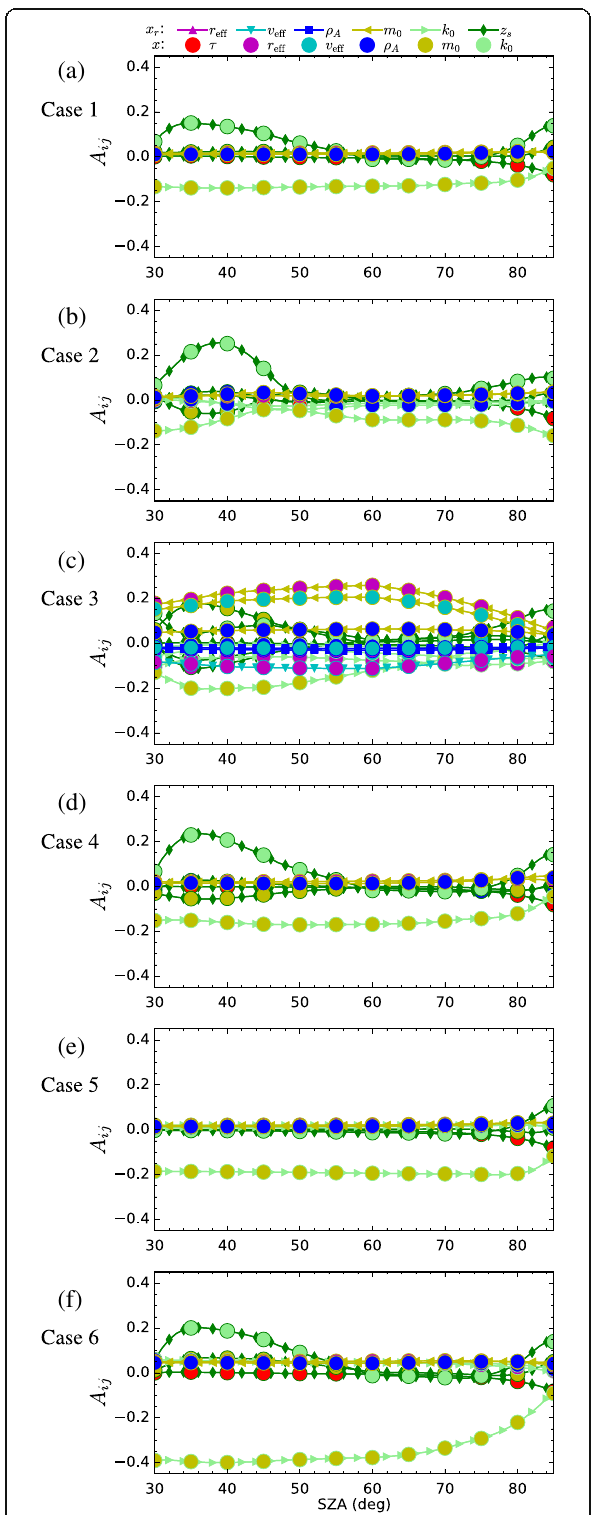
Fig. 9 Non-diagonal elements of AKM ( A ij = ∂ x r,i , / ∂ x j ) of dust model parameters. The lines with small symbols indicate the type of retrieved dust parameters ( x r ), while the large circles indicate the type of true dust parameters ( x ). Panels ( a ) - ( f ) show the relation between A ij and SZA for cases 1-6, respectively. The definitions of cases 1 – 6 are the same as in Fig. 7. These graphs are useful for the examination of error propagation from one dust parameter to another (see